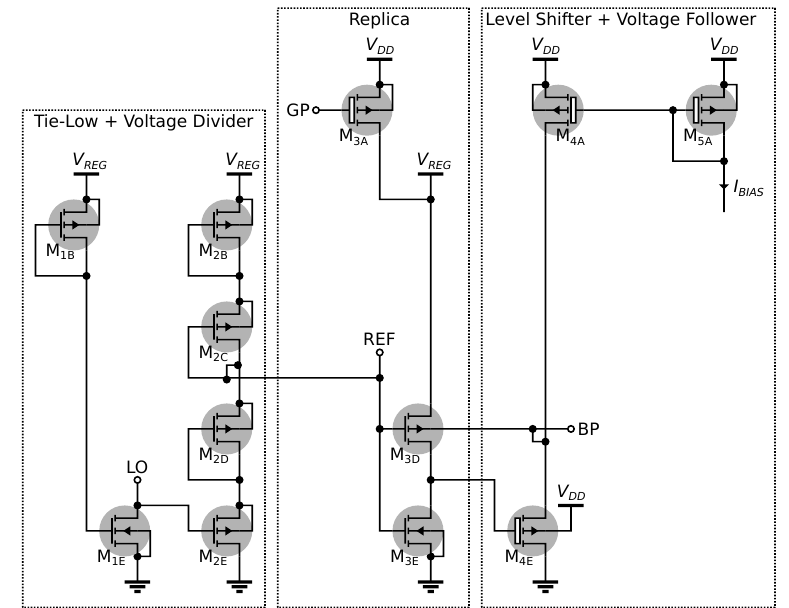
Figure 3. Quiescent voltage biasing circuit.